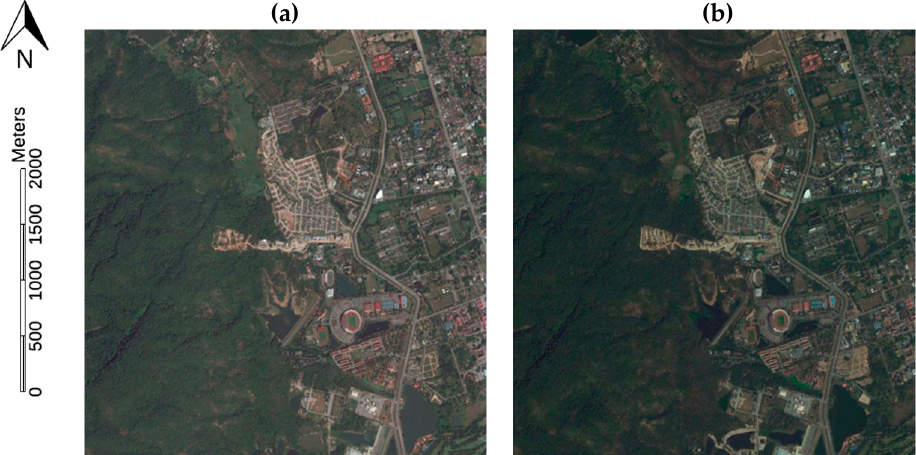
Figure 6. Optical image showing an example of the new constructions in the Chiang Mai testing area. The size of each image is 3.77 km × 3.97 km. ( a ) Time 1 image from 17 November 2015, ( b ) Time 2 image from 24 December 2017.